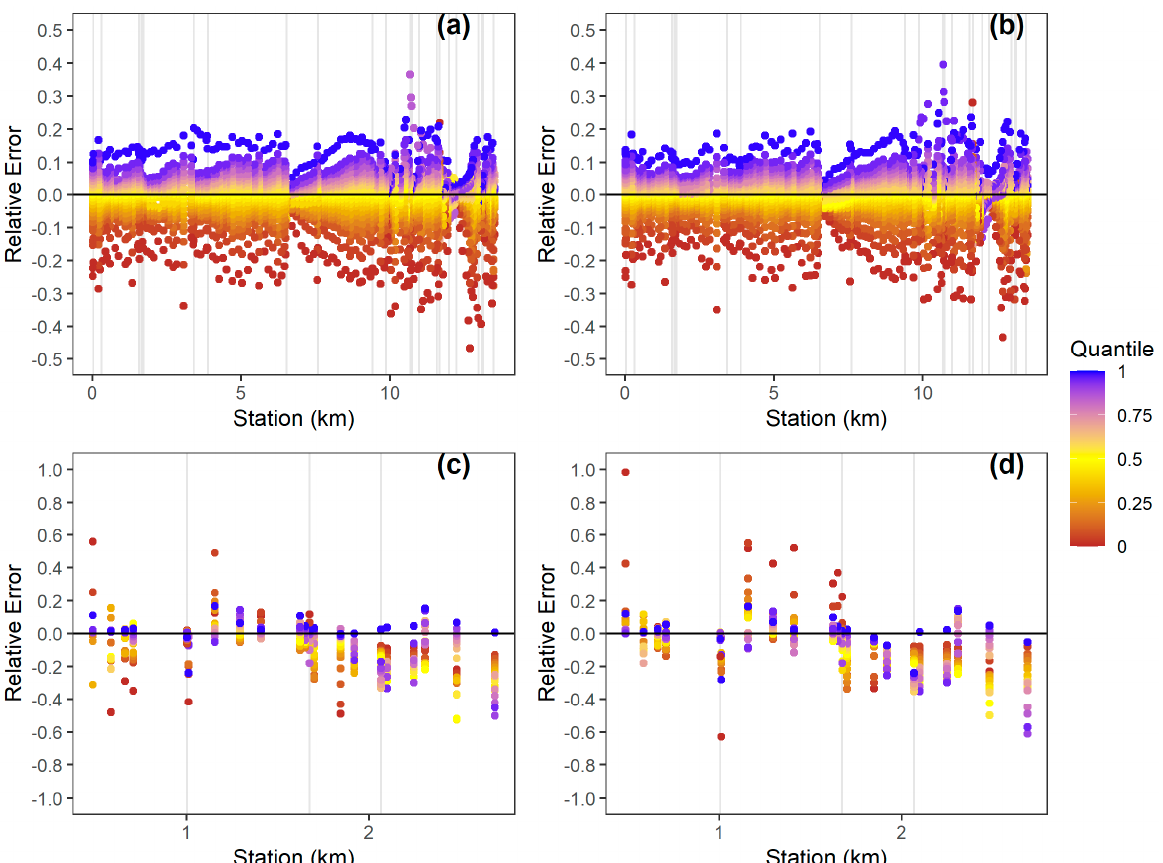
Figure 5. Relative depth errors in SUB relative to MCS for ( a ) the 1% AEP flood at Proctor Creek, ( b ) the 2% AEP flood at Proctor Creek, ( c ) the 1% AEP probability flood at Bronx Wash, and ( d ) the 2% AEP flood at Bronx Wash. Vertical gray lines indicate hydraulic structure locations.